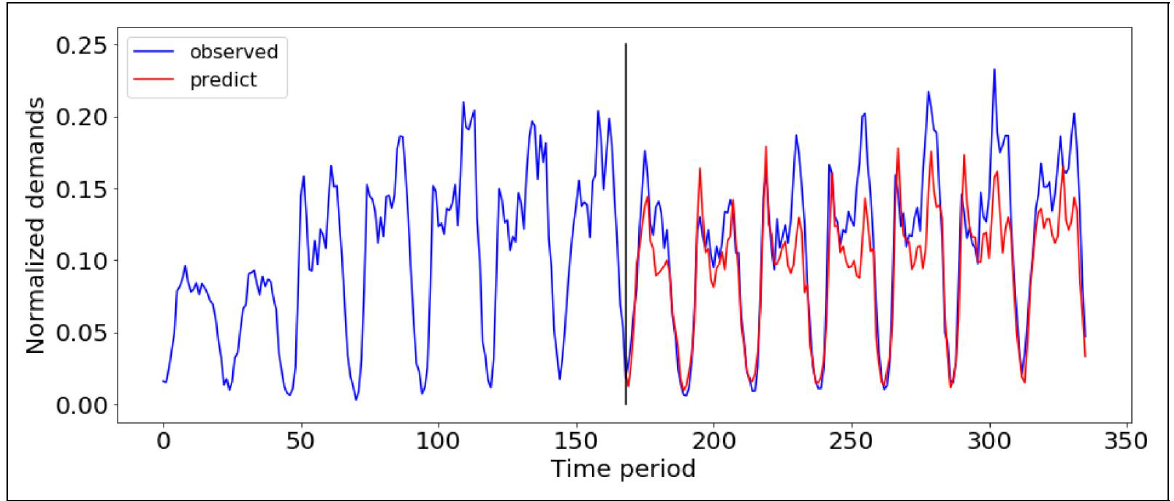
Figure 4. Hourly prediction of the taxi demand based on the LSTM